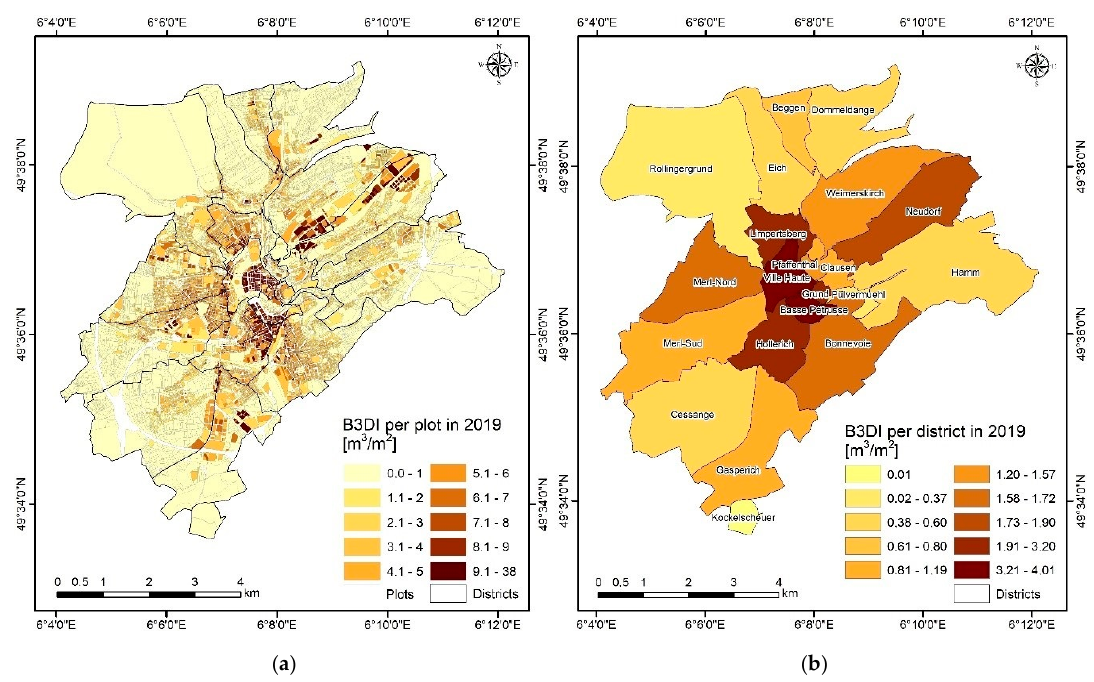
Figure 13. Building 3D Density Index per plot ( a ) and per district in Luxembourg City in 2019 ( b ).